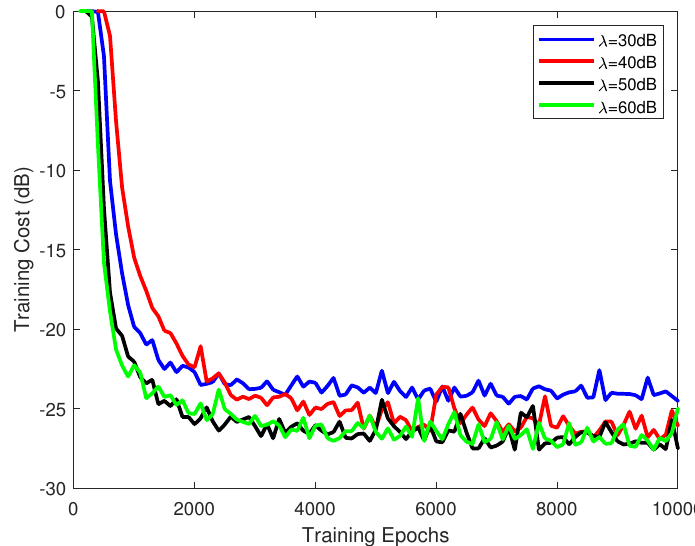
Figure 3. The cost performance comparison under different training SNRs.